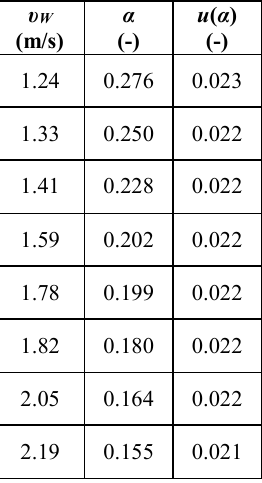
Table 2. Valuation of void fraction α and uncertainty values u ( α ) for the analyzed experiments